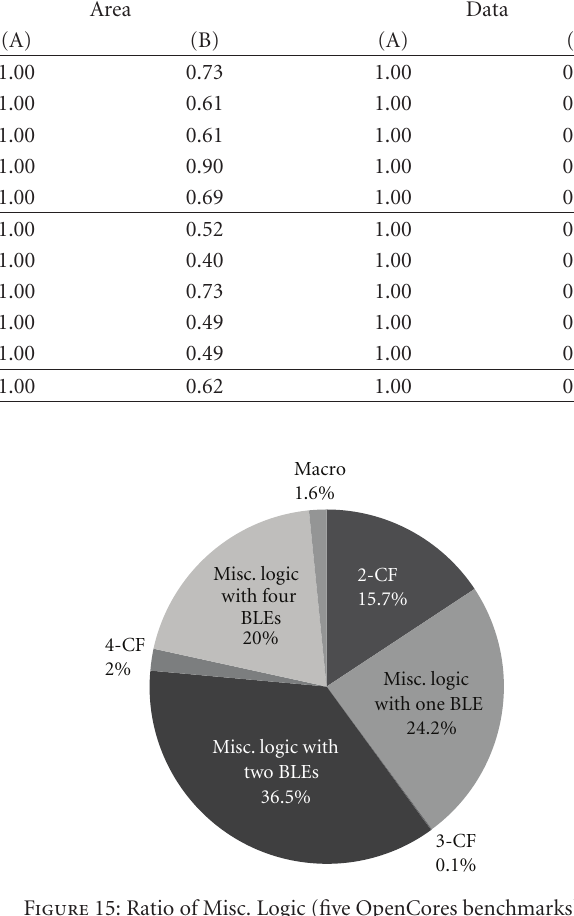
five OpenCores benchmarks include macroblock